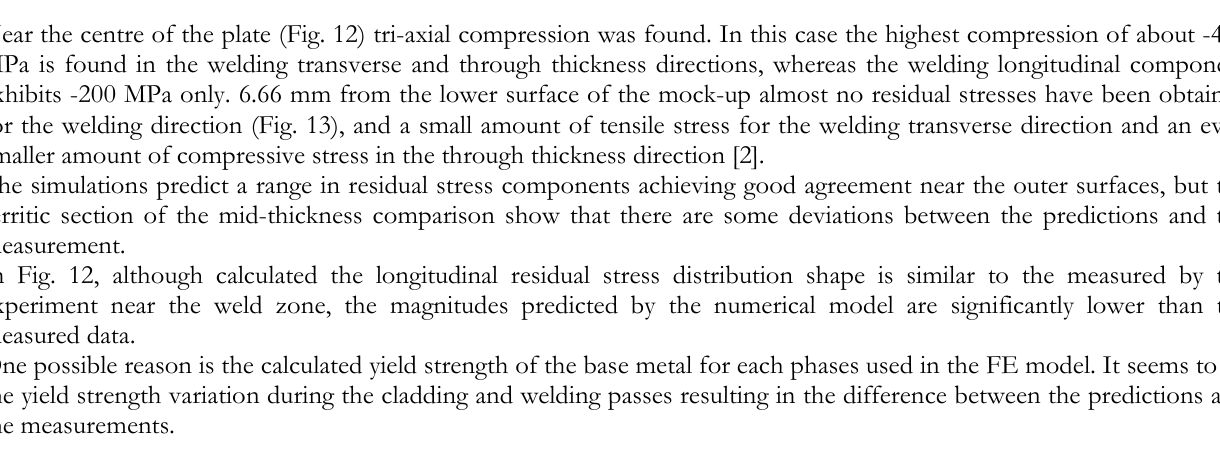
Figure 13: Estimate of residual stresses along a line 33.33 mm from the specimen